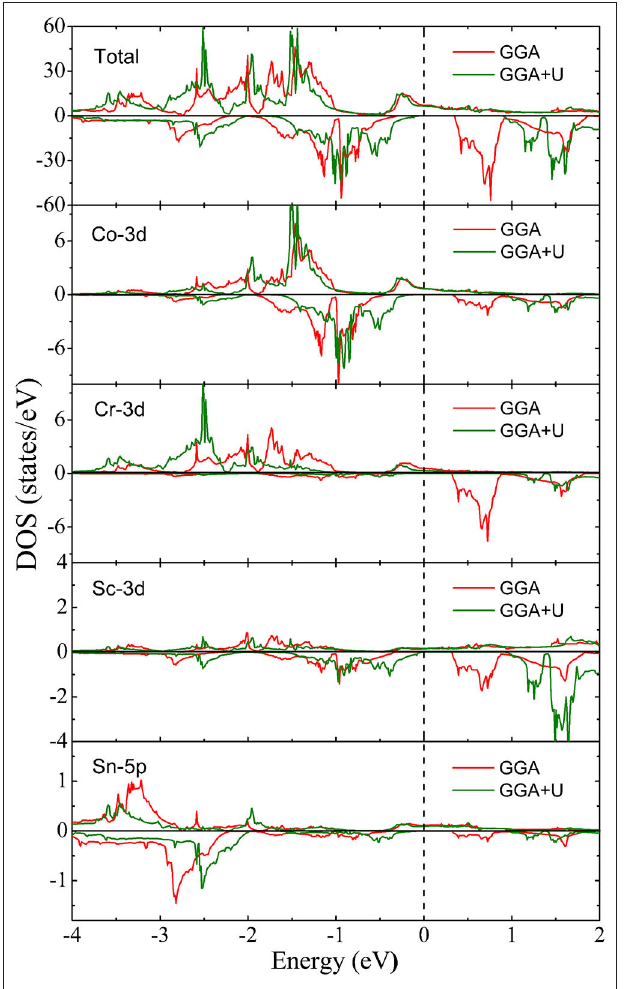
FIGURE 6 | Minority-spin CBM and VBM of CoCrScSn compound at different lattice constant. (A) GGA, (B) GGA +